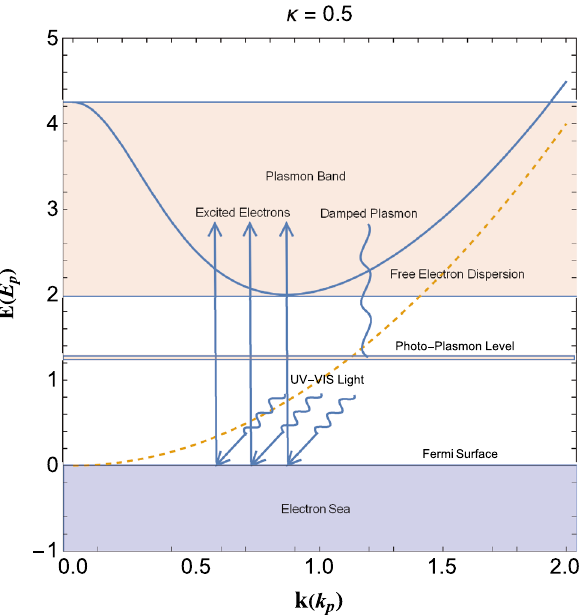
Figure 11. Schematic of the photo-plamonic phenomenon in the arbitrary degenerate electron gas at the interface region. The dashed curve represents the free electron dispersion and the solid curve denotes the damped plasmon